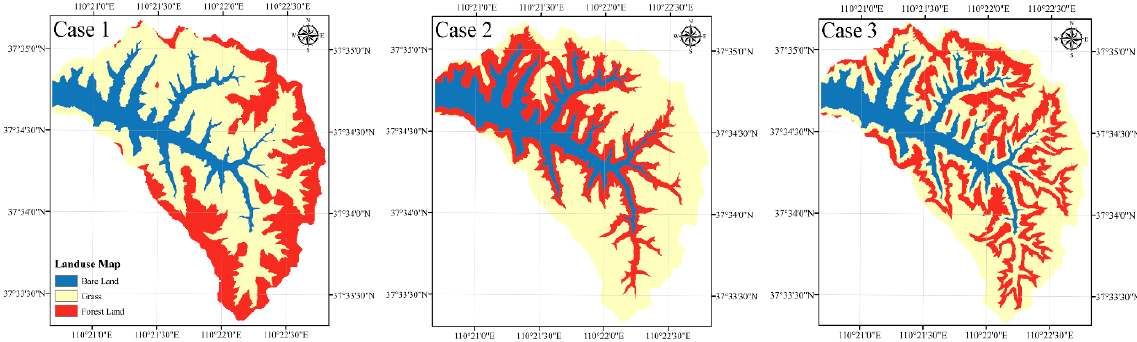
Figure 19. Different land use scenarios in Wangmaogou catchment.